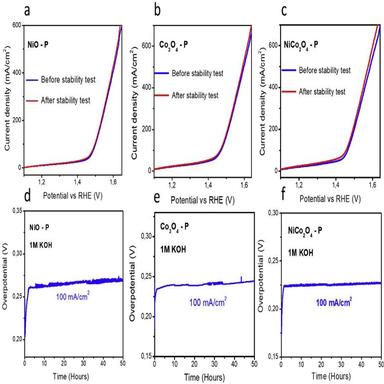
a. LSV curves of NiOeP before and after the durability test at a scan rate of 5 mVs-1 in 1.0 M KOH at 25 C, b. LSV curves of Co3O4eP before and after the durability test at a scan rate of 5 mVs-1 in 1.0 M KOH, c. a. LSV curves of NiCo2O4eP before and after the durability test at a scan rate of 5 mVs-1 in 1.0 M KOH, d. chronoamperometric response of NiOeP in 1.0 M KOH @ 100 mAcm¡2 , e. chronoamperometric response of Co3O4eP in 1.0 M KOH @ 100 mAcm¡2 , f. chronoamperometric response of NiCo2O4eP in 1.0 M KOH